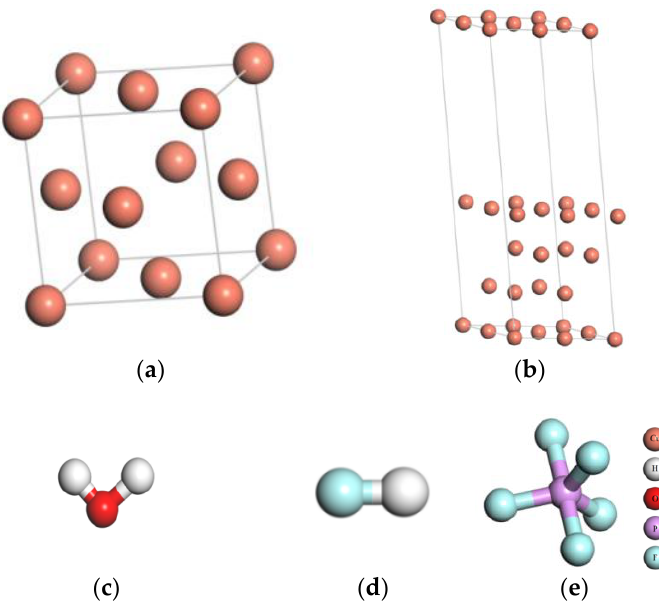
Figure 1. The models of Cu and three kinds of impurities: ( a ) the unit cell, ( b ) the surface periods slab model of the unit cell, ( c ) H 2 O, ( d ) HF, and ( e ) PF 5 .